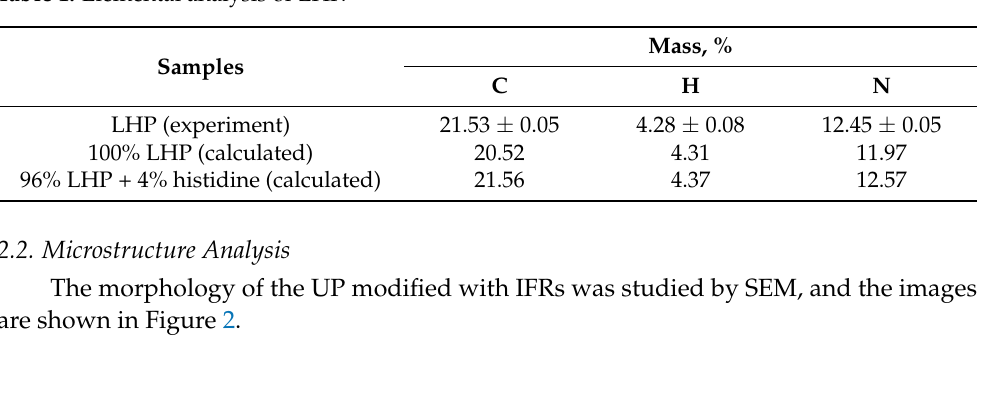
Table 1. Elemental analysis of